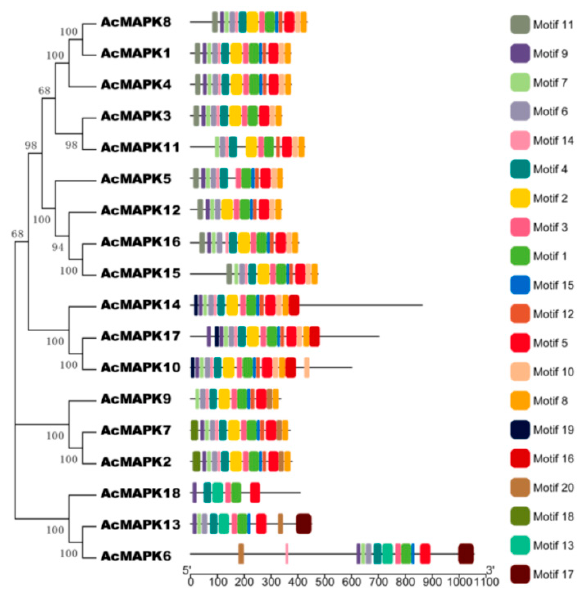
Figure 3. The conserved motifs of kiwifruit putative MAPKs according to the phylogenetic relationship. All motifs were identified online with the MEME program with the complete amino acid sequences of the 18 MAPKs. Different colors of the boxes represent different motifs in the corresponding position of each AcMAPK proteins. Detailed information of the 20 motifs is provided in Supplementary Material File 2.